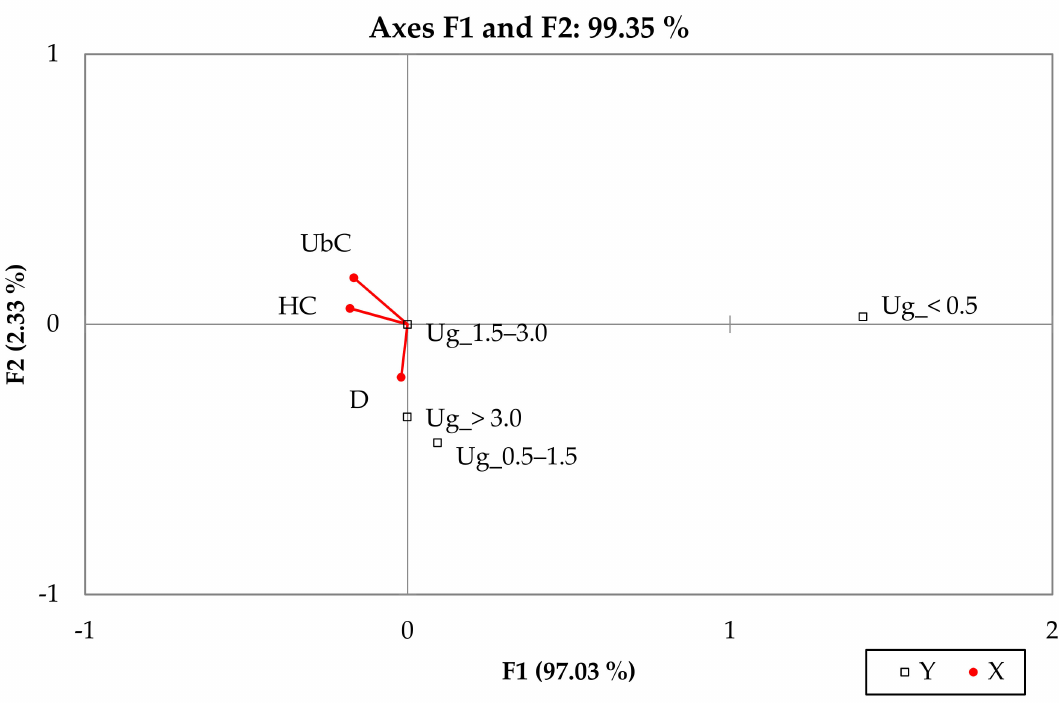
Figure 6. The vector distribution between two axes (RDA): pedunculate oak ( top ), sessile oak ( lower ) and their hybrid ( middle ) in four undergrowth (Ug) height classes (y) and their dependence from site density (D) and covering of underbrush (UbC) and herbaceous plant (HC)